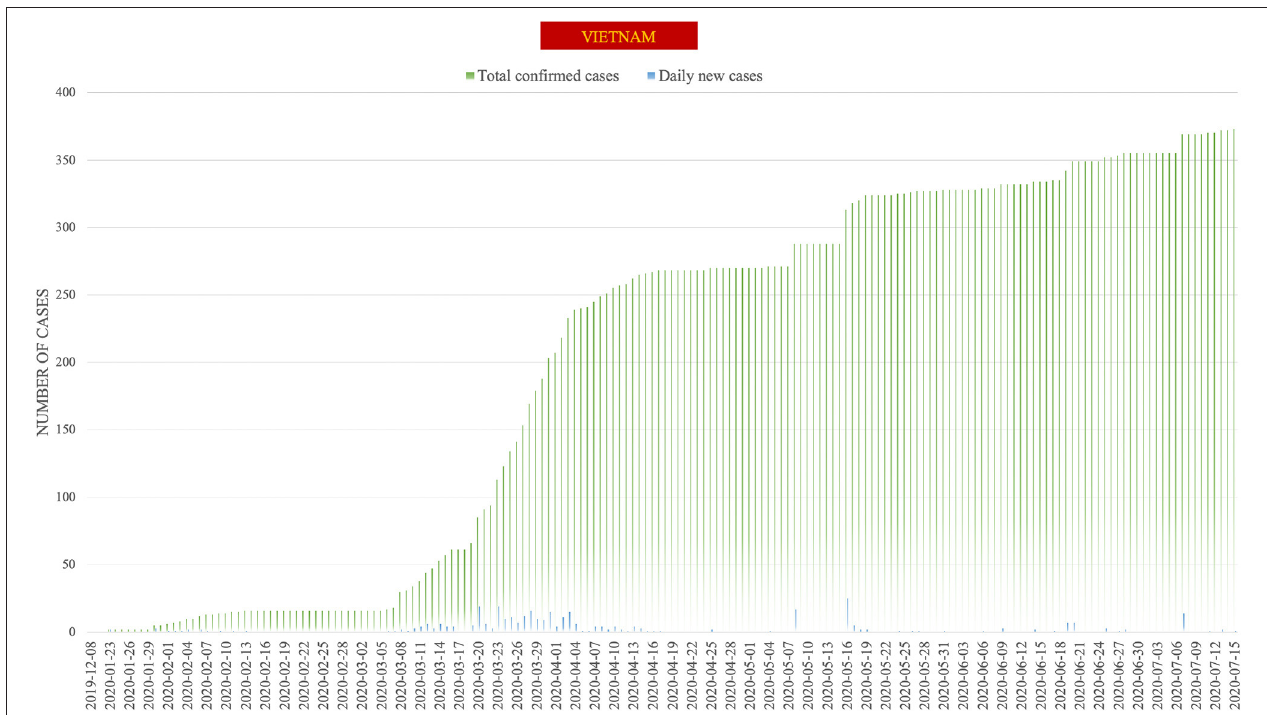
FIGURE 1 | Epidemic curve of new cases of COVID-19 in Vietnam. The total confirmed cases are presented in green and the daily new cases in blue. The using data was retrieved from the daily reports released by the World Health